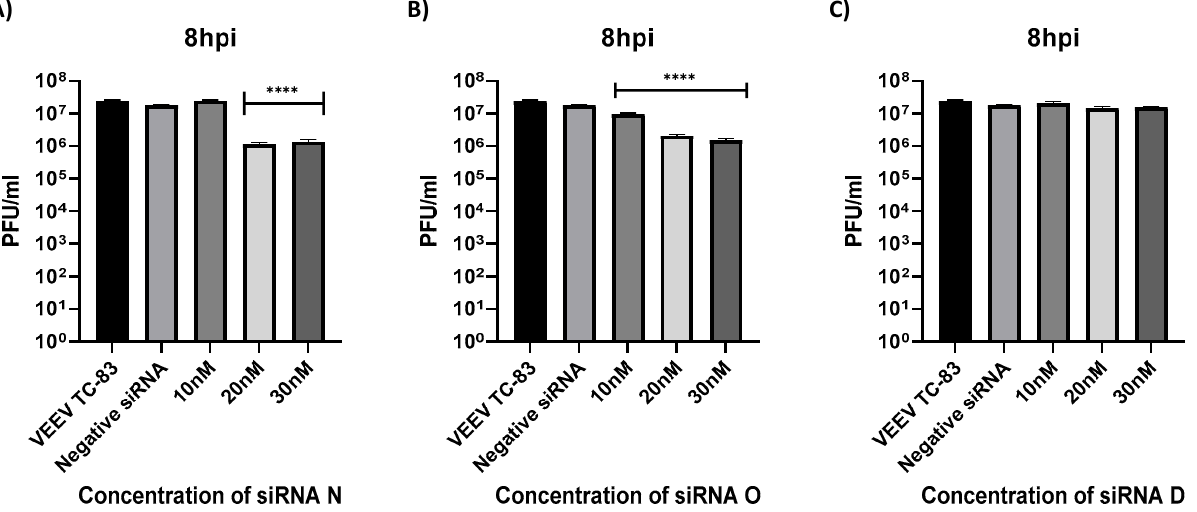
Figure 4. Dose dependent impact of VEEV siRNA. ( A – C ) 293T cells were transfected with either 10, 20 or 30 nM of siRNA. At 24 h post transfection, cells were infected with VEEV TC-83 at an MOI 0.1 and supernatants were collected at 8 hpi. Viral titers were determined via plaque assay. Graphs are representative of one independent experiment ( n = 3). **** p < 0.0001 compared to negative control siRNA.